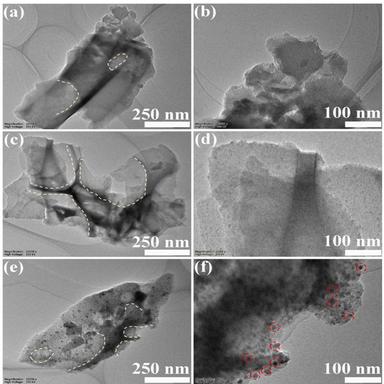
TEM images of (a, b) ZFO/C-400, (c, d) ZFO/C-450, and (e, f) ZFO/C-500.